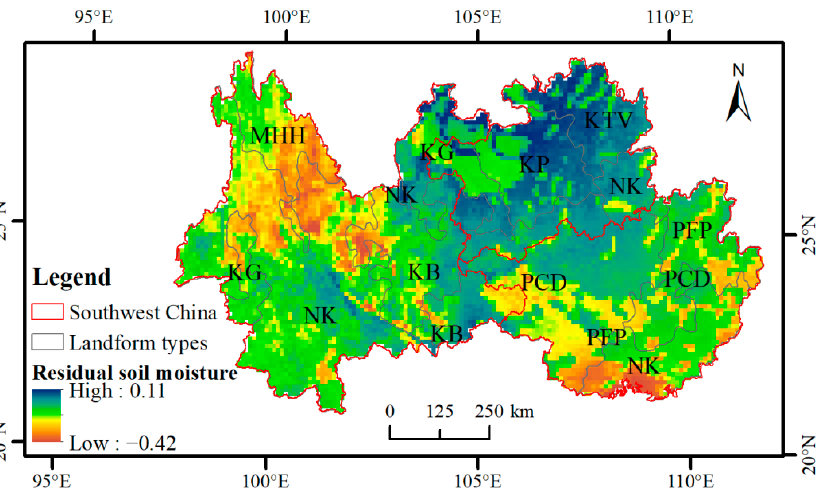
Figure 8. Residual soil moisture in the karst areas of Southwest China from 2000 to 2015 (PFP: peak forest plain; KG: karst gorge; NK: non-karst region; KB: karst basin; MHB: middle-high hill; PCD: peak cluster depression; KTV: karst trough valley; KP: karst